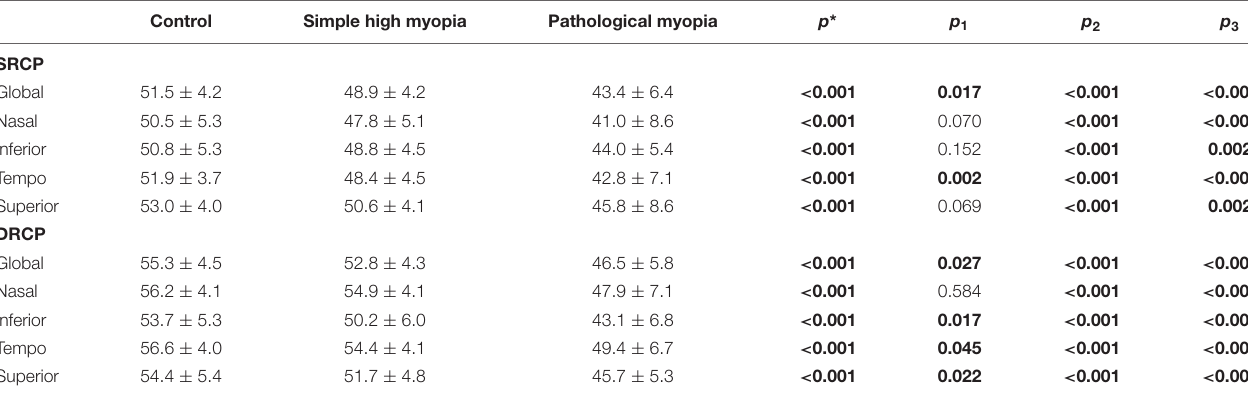
TABLE 4 | The macular retinal microvascular density (%) among the control, simple high myopia, and pathological myopia. Control Simple high myopia Pathological